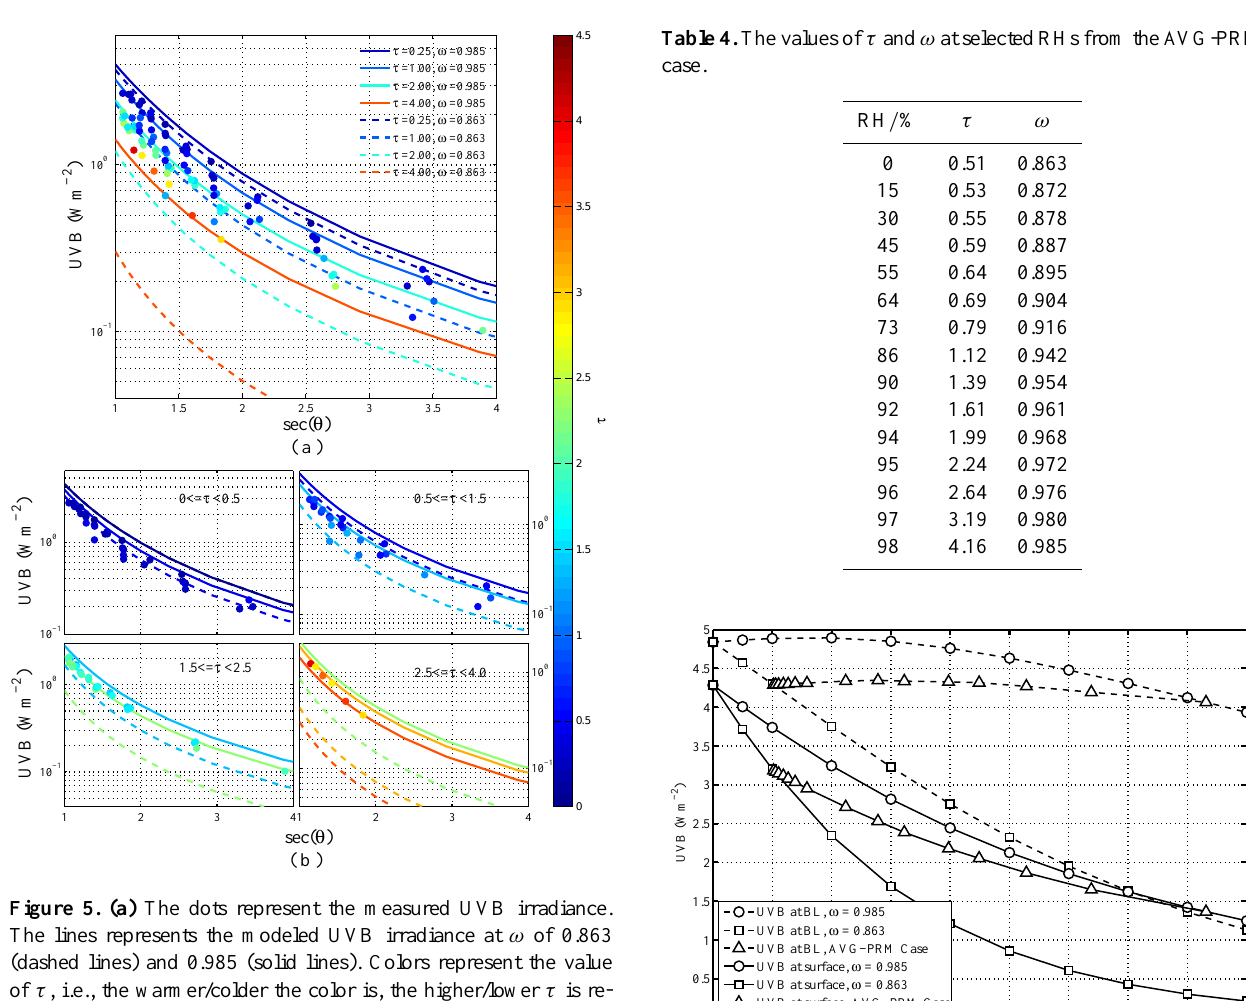
And at the height of 1 km, J NO